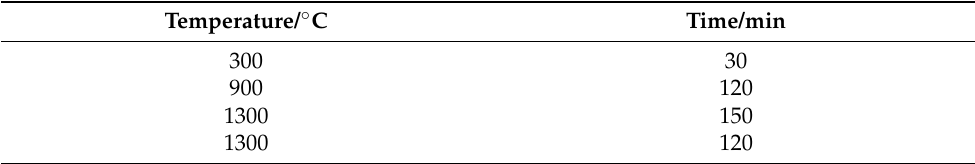
Table 2. Heating system for synthesizing C 4 A 3